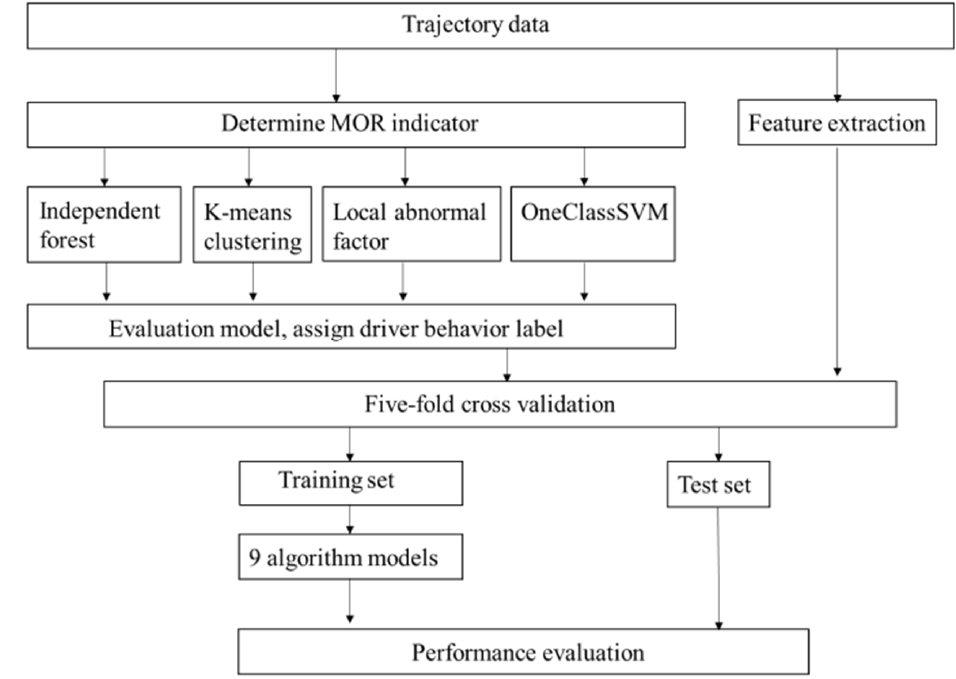
Figure 1. Technical roadmap of Dangerous Driving Behavior Recognition.